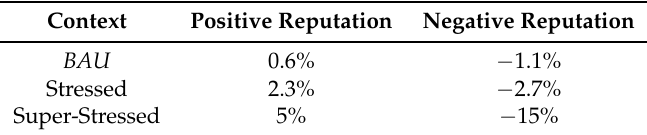
Table 1. Effect of annual reputation change on profit after